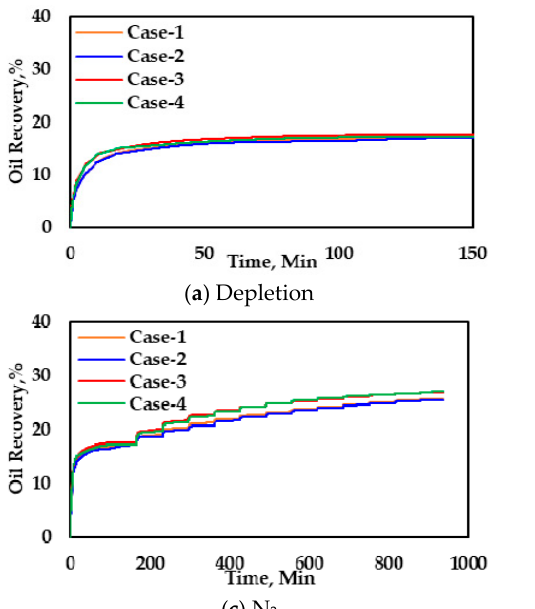
Figure 25. Oil saturation comparison with gravity effect (ij profile).